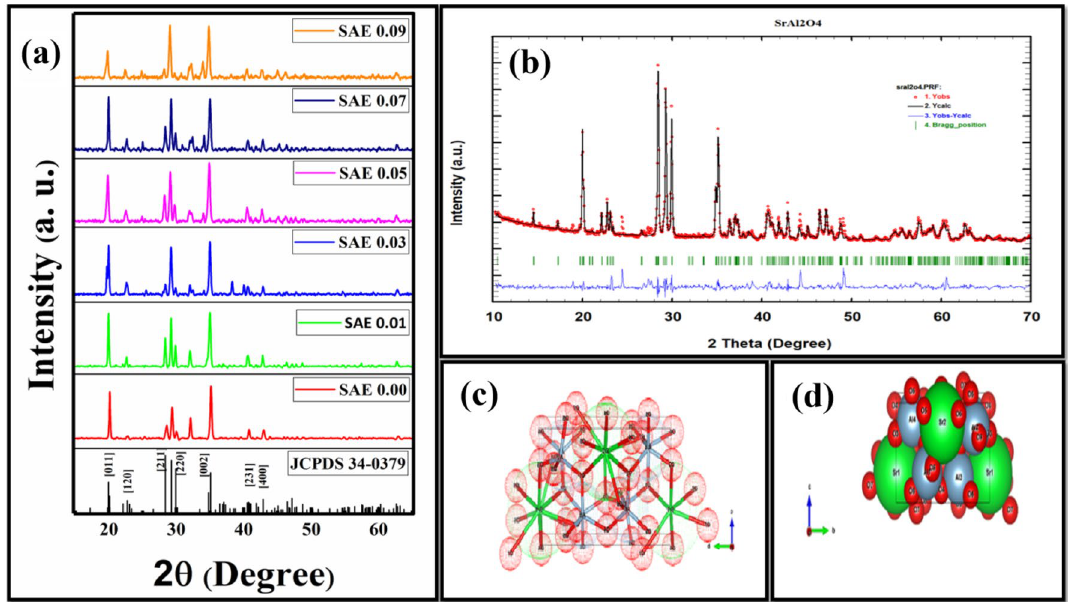
Figure 2. XRD spectra ( a ) Typical Rietveld refinement Crystallographic image of SrAl 2 O 4 ( b ) Crystal structure of